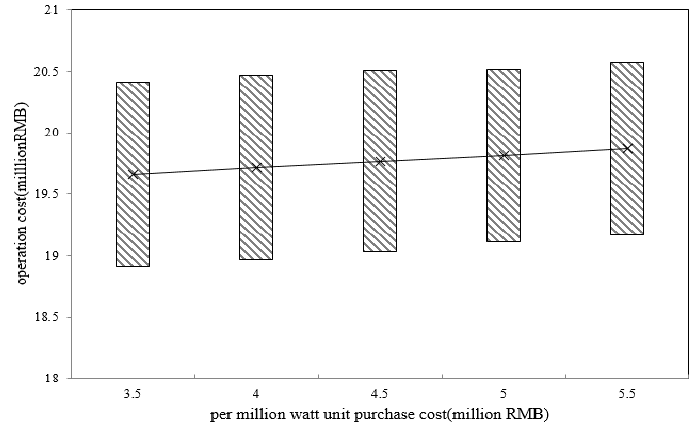
Figure 7. Optimal operation cost interval under different unit purchase costs.